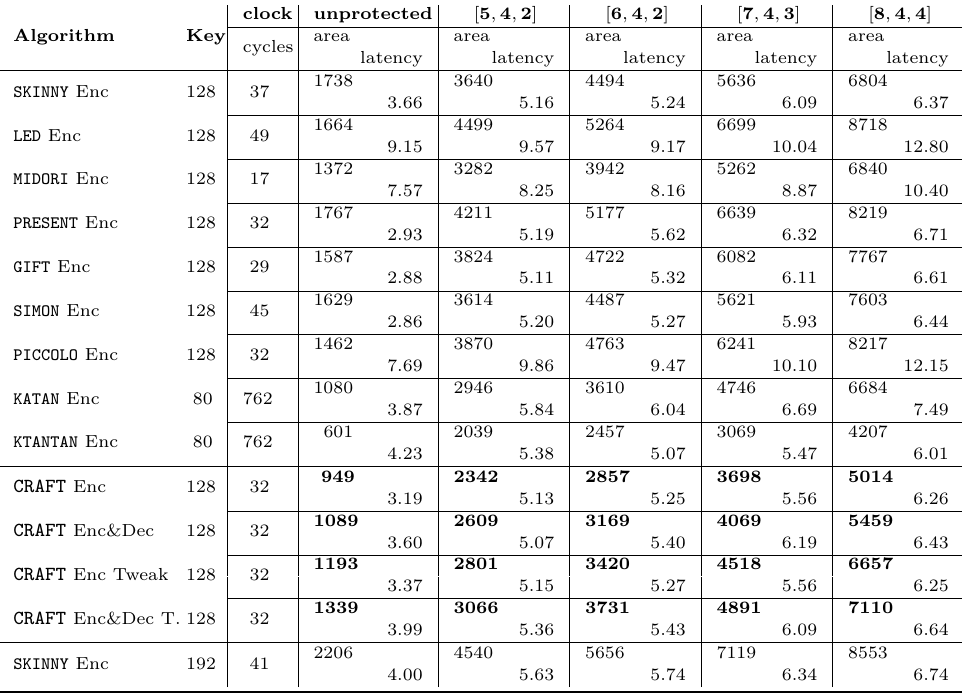
Table 6: Area (GE) and Latency (ns) comparison of round-based implementations consider- ing an M -bounded univariate adversary with an [ n, k, d ] code, using the IBM 130 nm t = d − 1 ASIC library, partially borrowed from